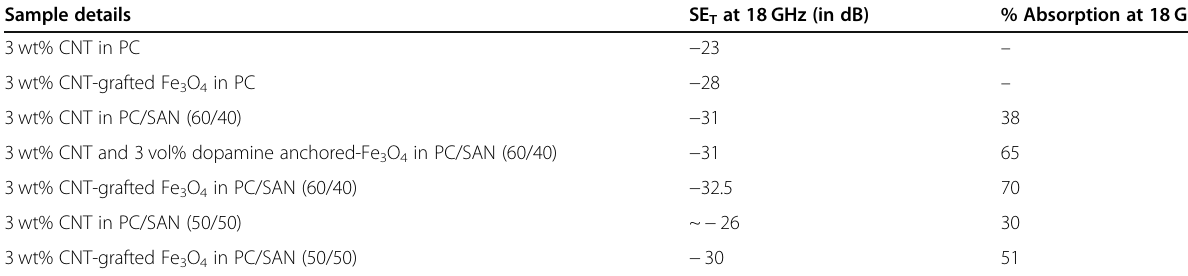
Table 3 SE T and % absorption for PC and PC/SAN composites Sample